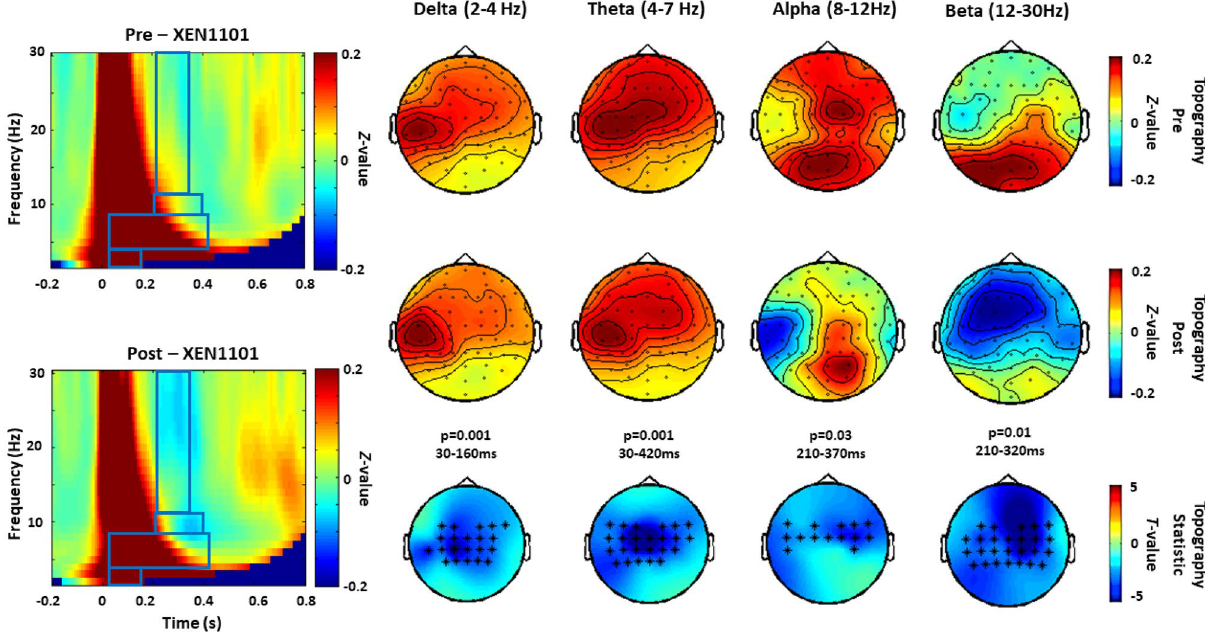
Figure 4. TRSP modulated by XEN1101 (experiment 2). Grand averages of the time–frequency representation (TFR averaged over ROI channels) of TRSP oscillations recorded before (pre) and after (post) the intake of XEN1101 are shown on the left panel. The blue boxes correspond to the time and frequency windows when comparisons between pre and post conditions showed significant drug effects. Topographical distribution of drug-related effects on the of delta (p = 0.001, 30–160 ms), theta (p = 0.001, 30–420 ms), alpha (p = 0.03, 210–370 ms) and beta (p = 0.01, 210–320 ms) band power are reported for pre and post drug conditions on the right panel. Significant electrodes within the bilateral 27 electrode ROIs are represented with asterisks in the t-statistic